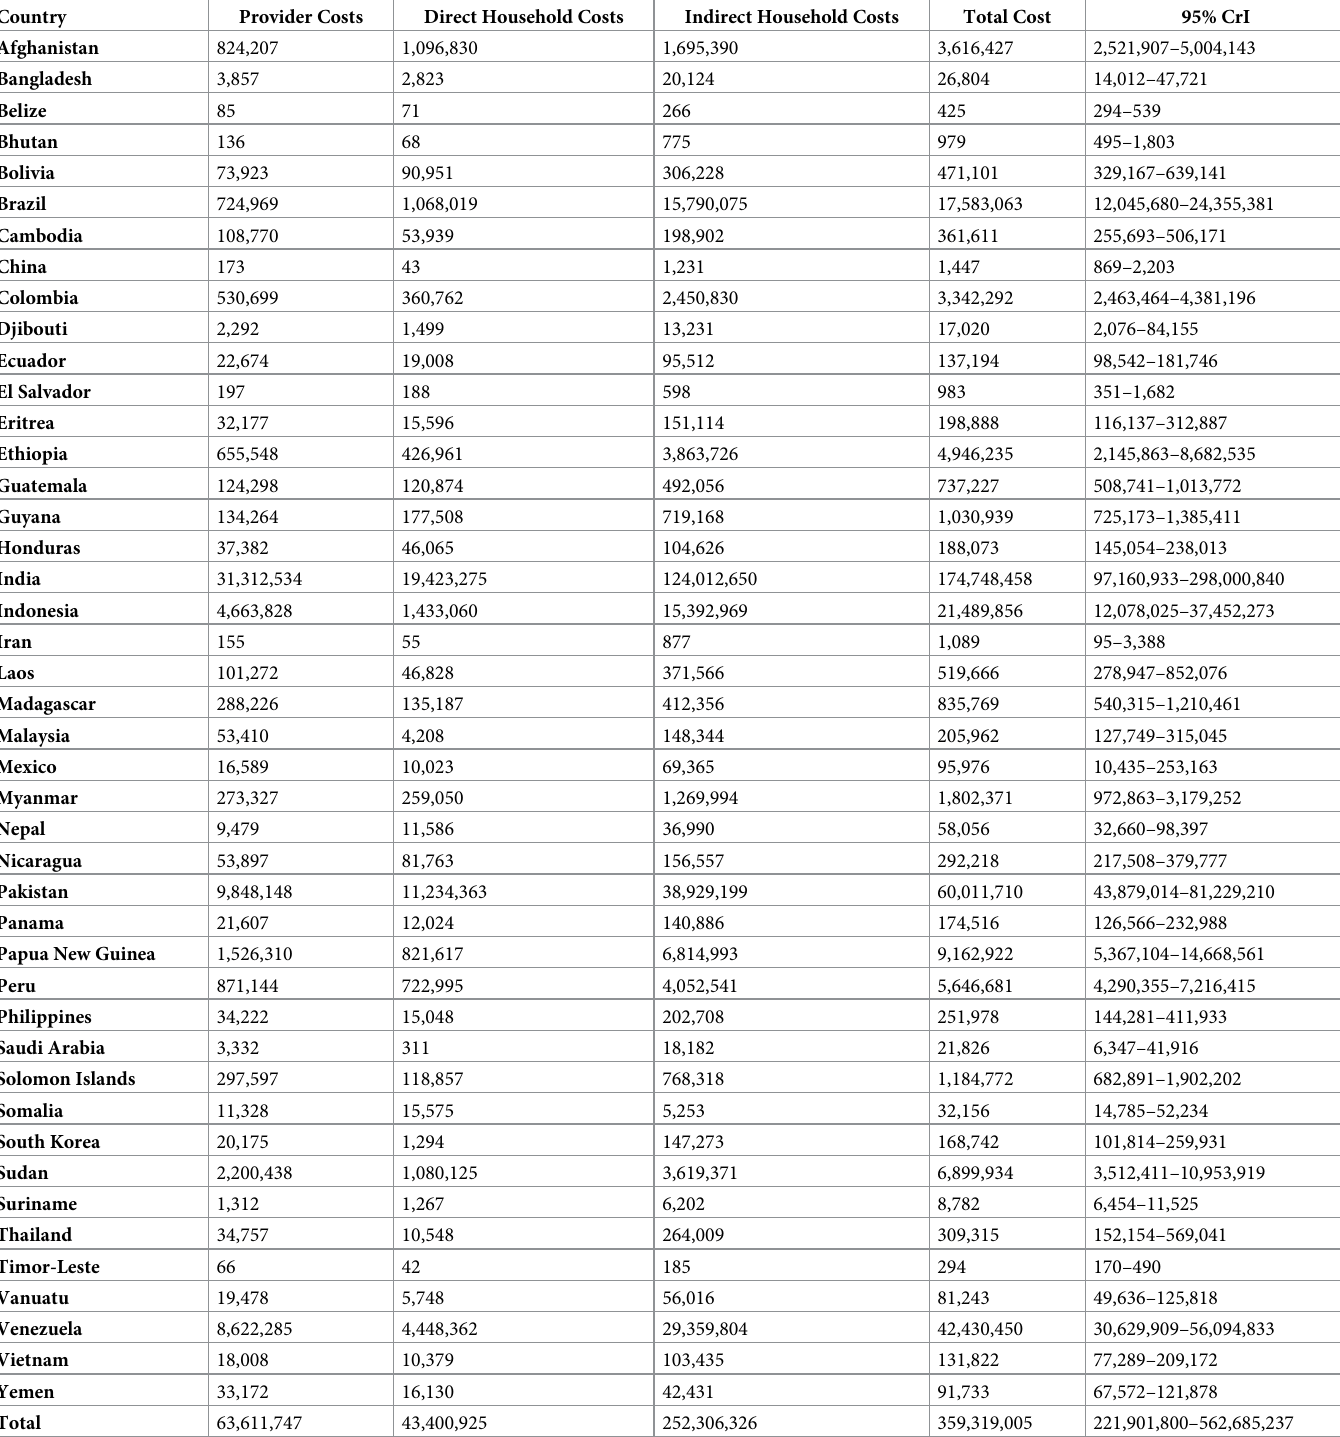
Table 2. Baseline global costs for vivax malaria by country. Costs are in 2017 United States Dollars. The provider cost per case can be found in S3 Table.